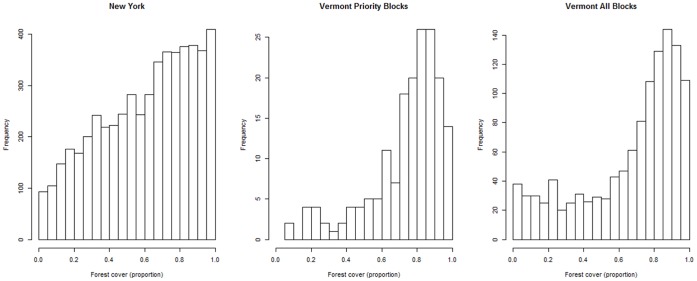
Histograms of forest cover across atlas blocks in the states of Vermont and New York.The frequency of atlas blocks with a particular proportion of forest cover in each of the states. The histograms illustrate that many atlas blocks in both states have high (e.g. more than 0.6, or 60%) levels of forest cover, but also indicate that forest cover across the Vermont atlas blocks is more or less homogeneous (high cover) while atlas blocks in New York have a more variable range of forest cover (i.e. there are many blocks with low forest cover as well). The forest cover of the priority atlas blocks in Vermont seems a representative sample of the forest cover of all atlas blocks in Vermont.